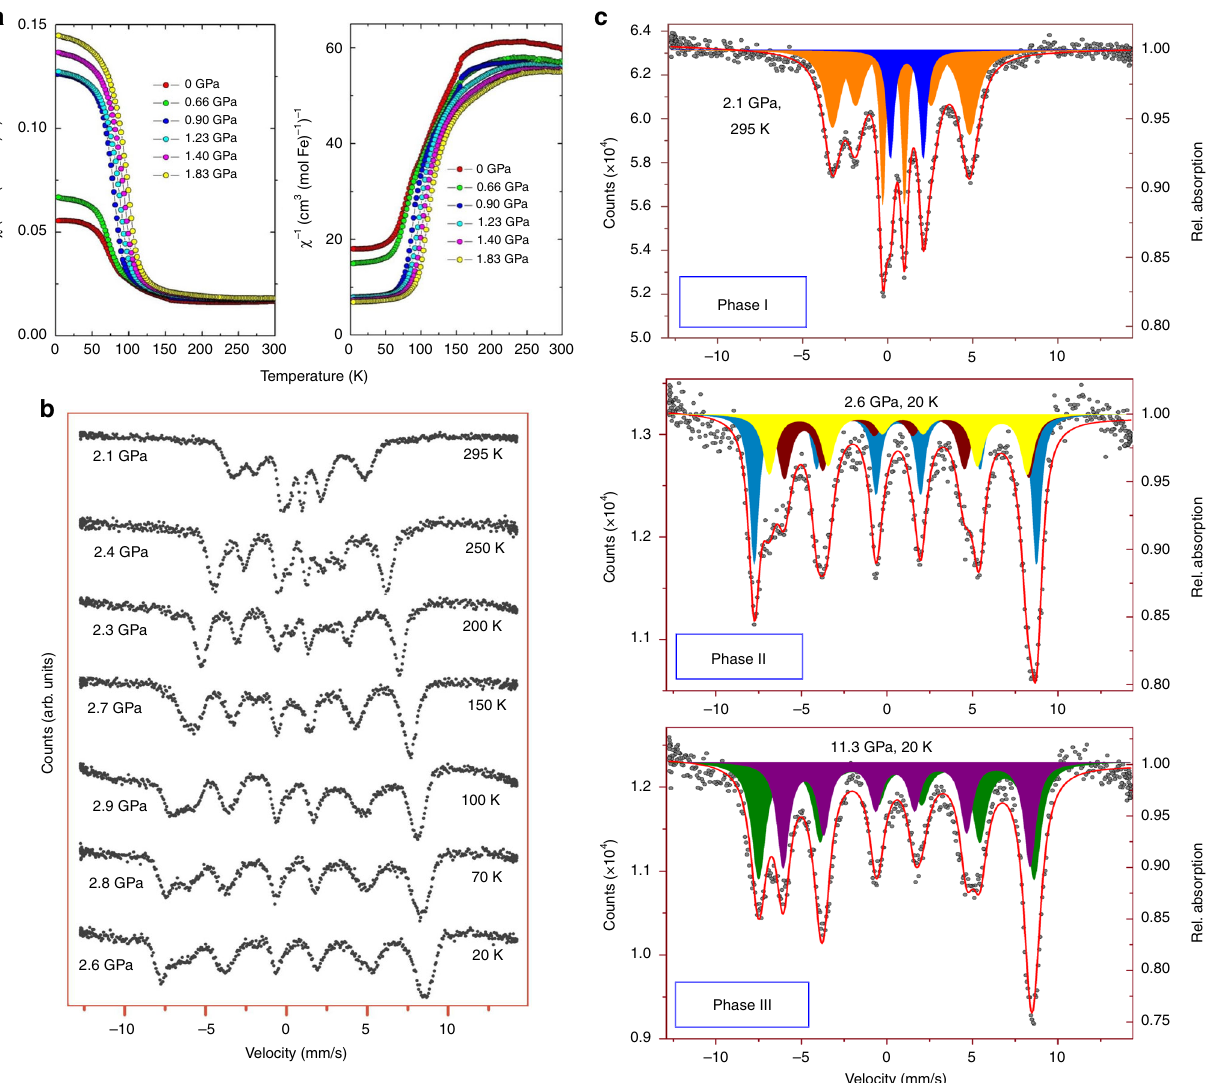
Fig. 8 Magnetic susceptibility and Mössbauer spectra of Fe 4 O 5 . a Temperature dependence of magnetic susceptibility and inverse magnetic susceptibility measured at different hydrostatic pressures in a fi eld of 0.5 T under fi eld cooling. b Evolution of Mössbauer spectra upon cooling at about 2 – 3 GPa. Broadening of the fi rst (low-velocity) line of the sextet starting at 150 K indicates charge ordering. c Representative Mössbauer spectra of different phases of Fe 4 O 5 collected at different pressures and temperatures. The spectrum of phase I can be re fi ned by superposition of a paramagnetic doublet (blue) assigned to iron in the trigonal prisms and a magnetic sextet (orange) assigned to Fe in the octahedra in a mixed-valence state. The spectra of phases II and III exhibit a complex distribution of hyper fi ne fi elds and can be re fi ned by superposition of